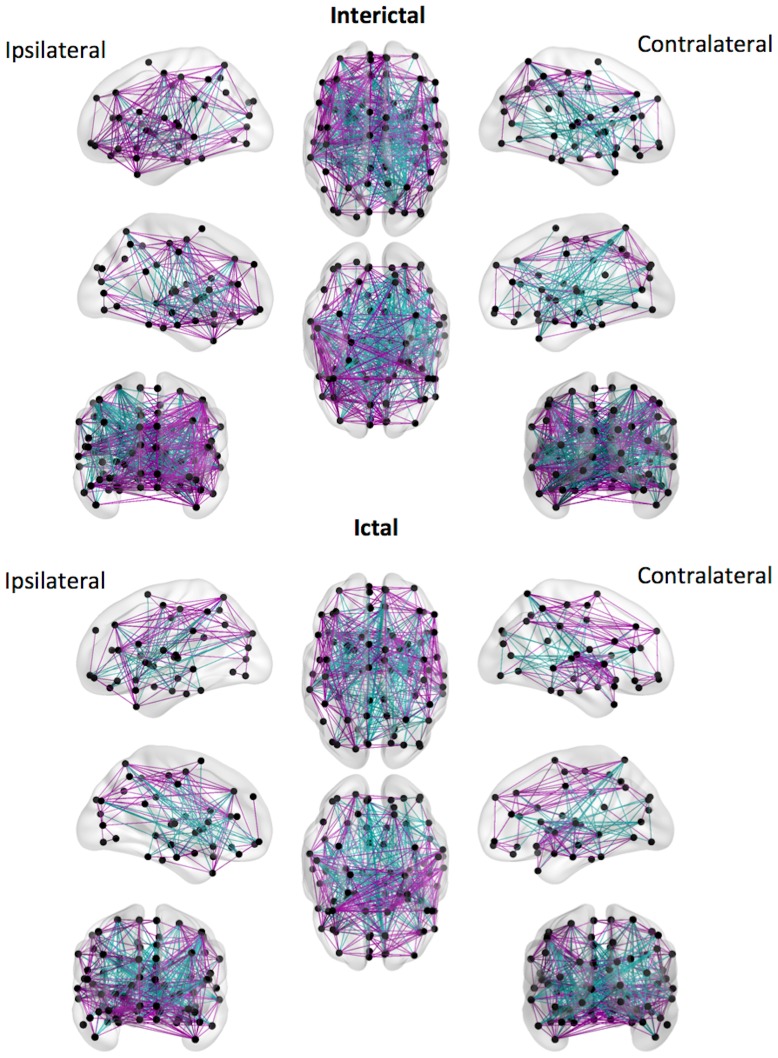
The anatomical distribution of positive (purple) and negative (cyan) links during the ictal and interictal states.A change in the number and distribution of positive and negative links can be observed in the ictal state compared with the interictal state. In the ictal state, a higher number of positive links is observed over the ipsilateral temporal lobe, with a concurrent reduction of positive links in extra-temporal regions.